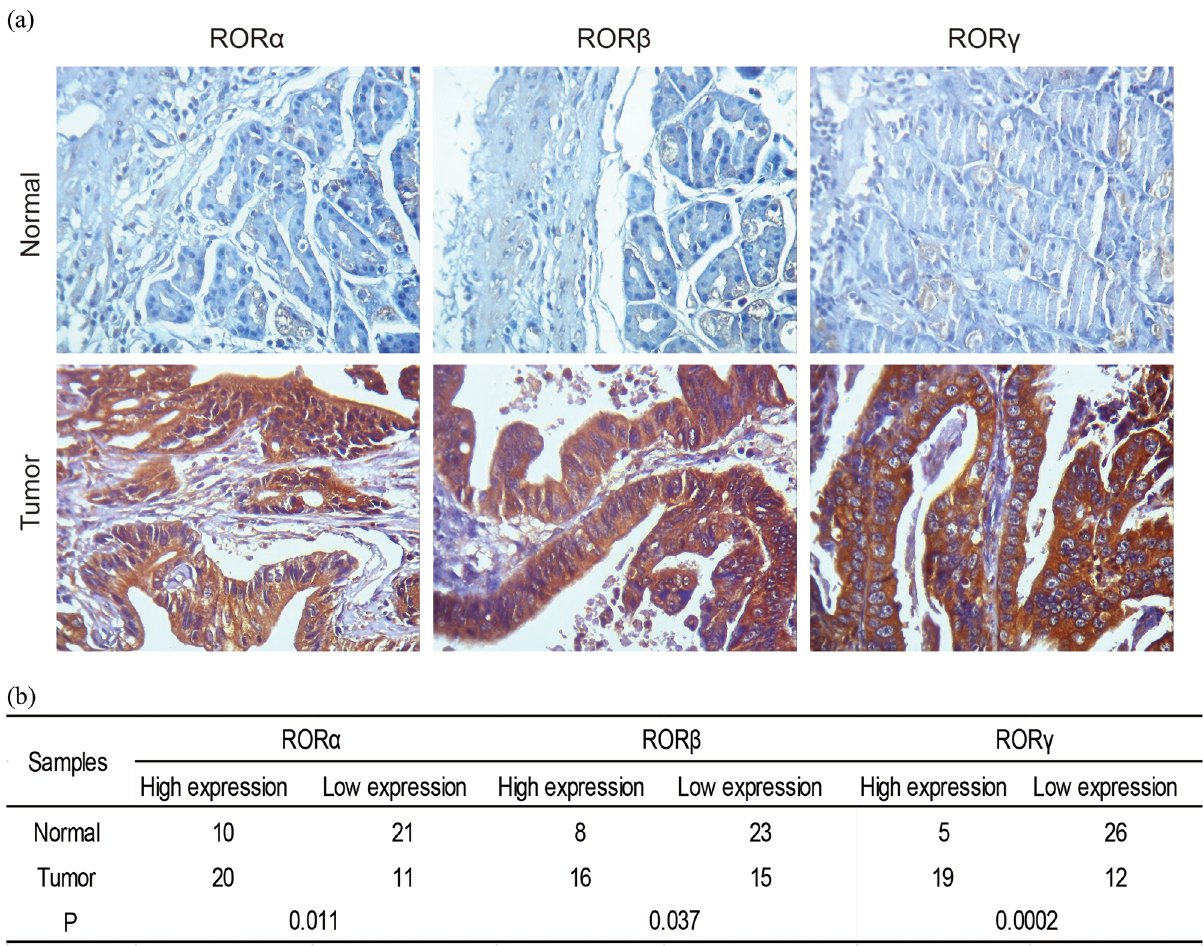
Figure 5: ROR α , ROR β , and ROR γ were overexpressed in human GC tissues. ( a ) The expression levels of ROR α , ROR β , and ROR γ in GC and surrounding tissues were detected by immunohistochemistry. Photomicrographs were taken at 400 × magni fi cation. ( b ) Analysis of immunohistochemical